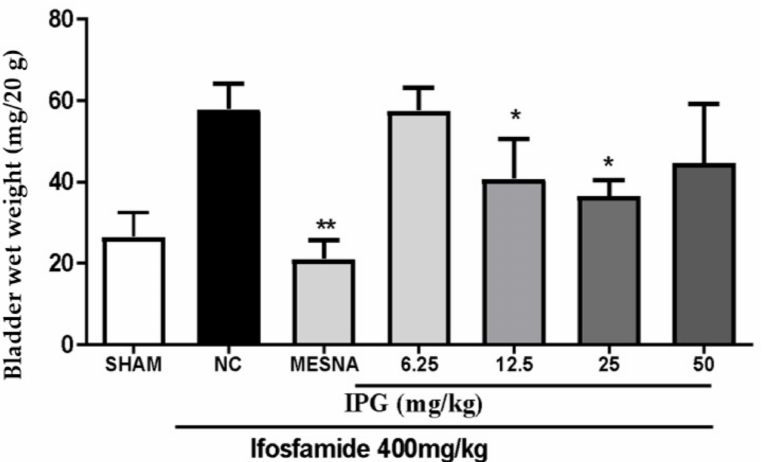
Figure 2. Effects of IPG on bladder wet weight in ifosfamide-induced hemorrhagic cystitis. Data are expressed as mean ± SEM ( n = 6) of the ratio of bladder wet weight to animal mass after the experimental protocol (mg/20 g of animal weight). The values were compared with the negative control (NC, Tween/Saline), by one-way analysis of variance (ANOVA) followed by the Bonferroni test; * p < 0.05, ** p <